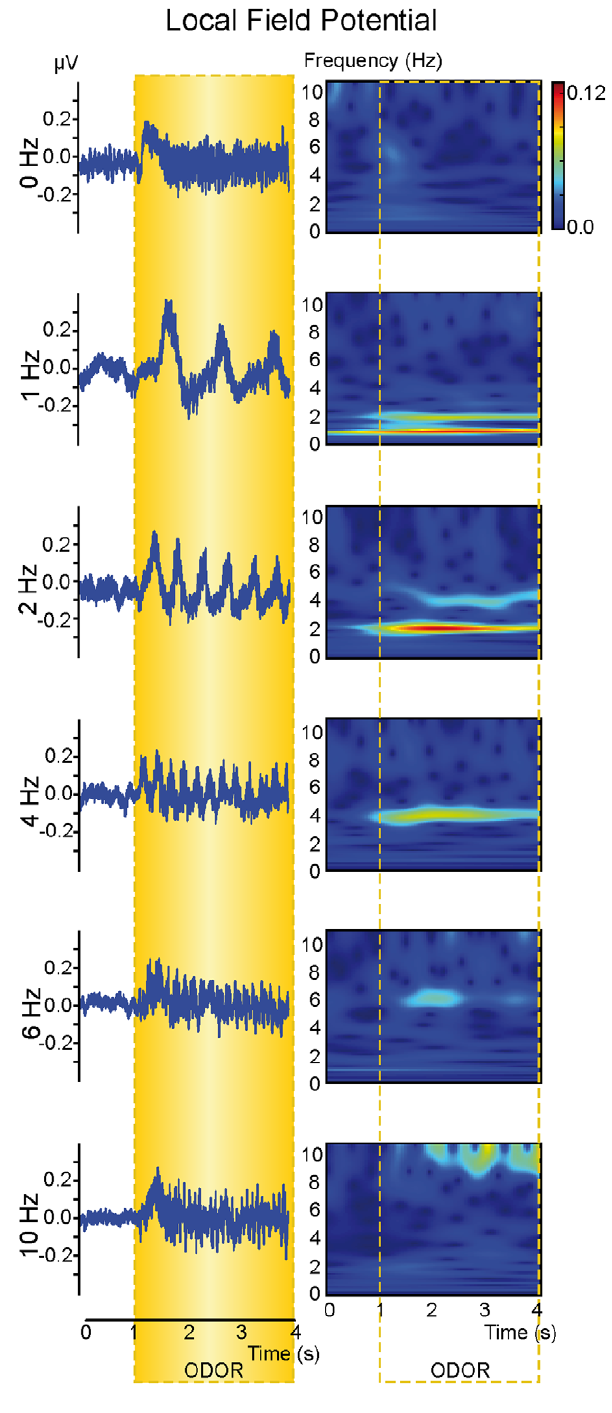
Figure 3. Impact of sniffing frequency on LFP signals. An example of local field potentials recorded from the granule cell layer (left) and corresponding time-frequency representations (right). The responses were recorded using a 1000 ml/min flow rate. The color scale (arbitrary unit) was the same for all time-frequency representations. Yellow box indicates odor stimulation period. difference can be first explained by our imaging approach. Indeed, all previous studies focusing on the impact of sniffing frequency were based on Ca2 + imaging of presynaptic activity. Voltage-